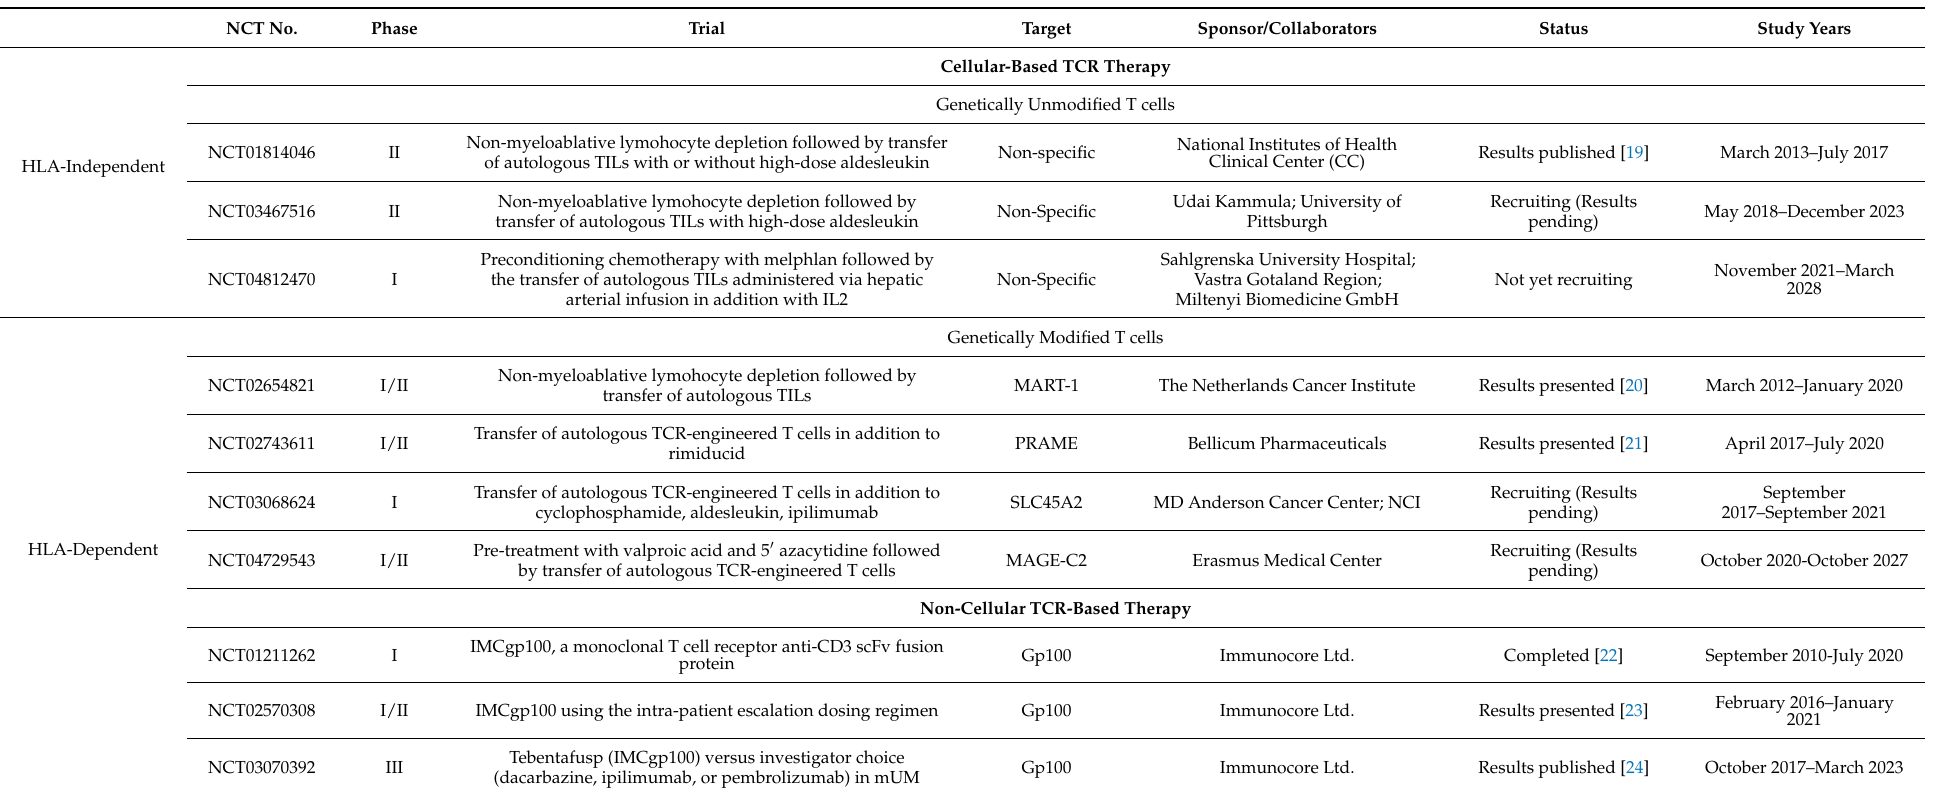
Table 1. TCR-based clinical trials in metastatic uveal melanoma